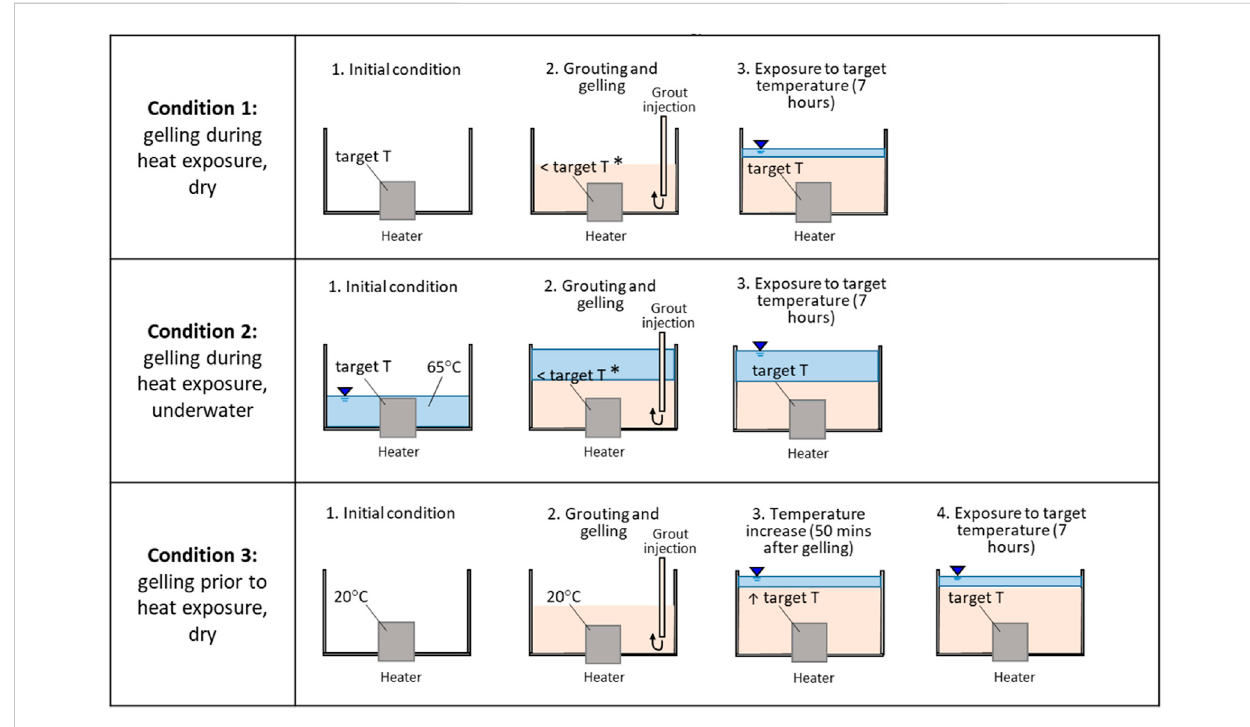
FIGURE 3 Schematic representation of grouting conditions. (*Temporary cooling of the heater due to injection of grout at room